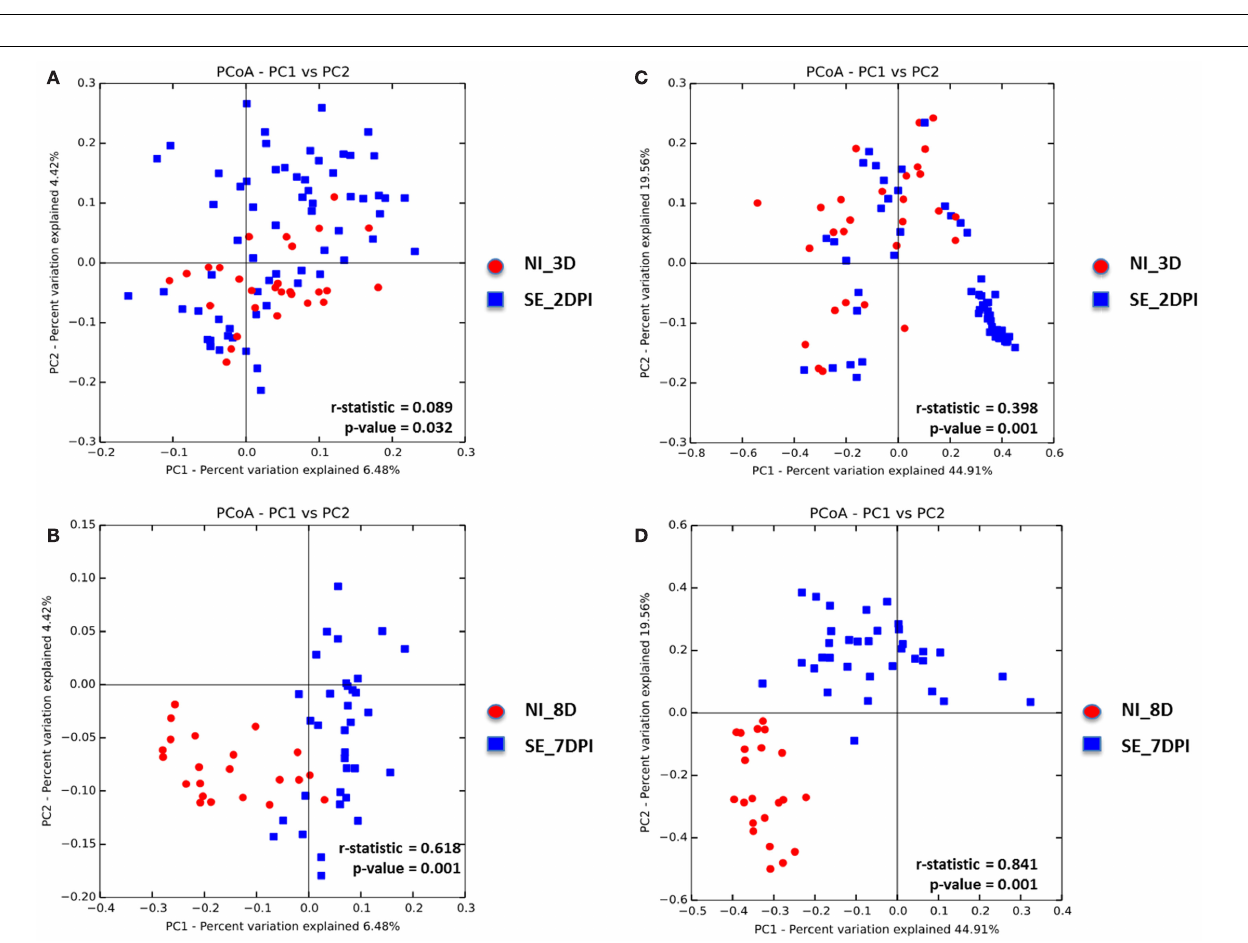
FIGURE 10 | Principal coordinate analysis (PCoA) based on (A,B) unweighted and (C,D) weighted UniFrac distances was analyzed for same-age group comparison between non-infected and infected chicks . ANOISM with 999 permutations was used to detect the statistical significant difference between microbial communities of different groups, where both r and p value is reported. Abbreviations: NI_3D, non-infected chicks at 3days old; SE_2DPI, S. Enteritidis-infected chicks at 2days post infection; NI_8D, non-infected chicks at 8days old; SE_7DPI, S. Enteritidis-infected chicks at 7days post infection.